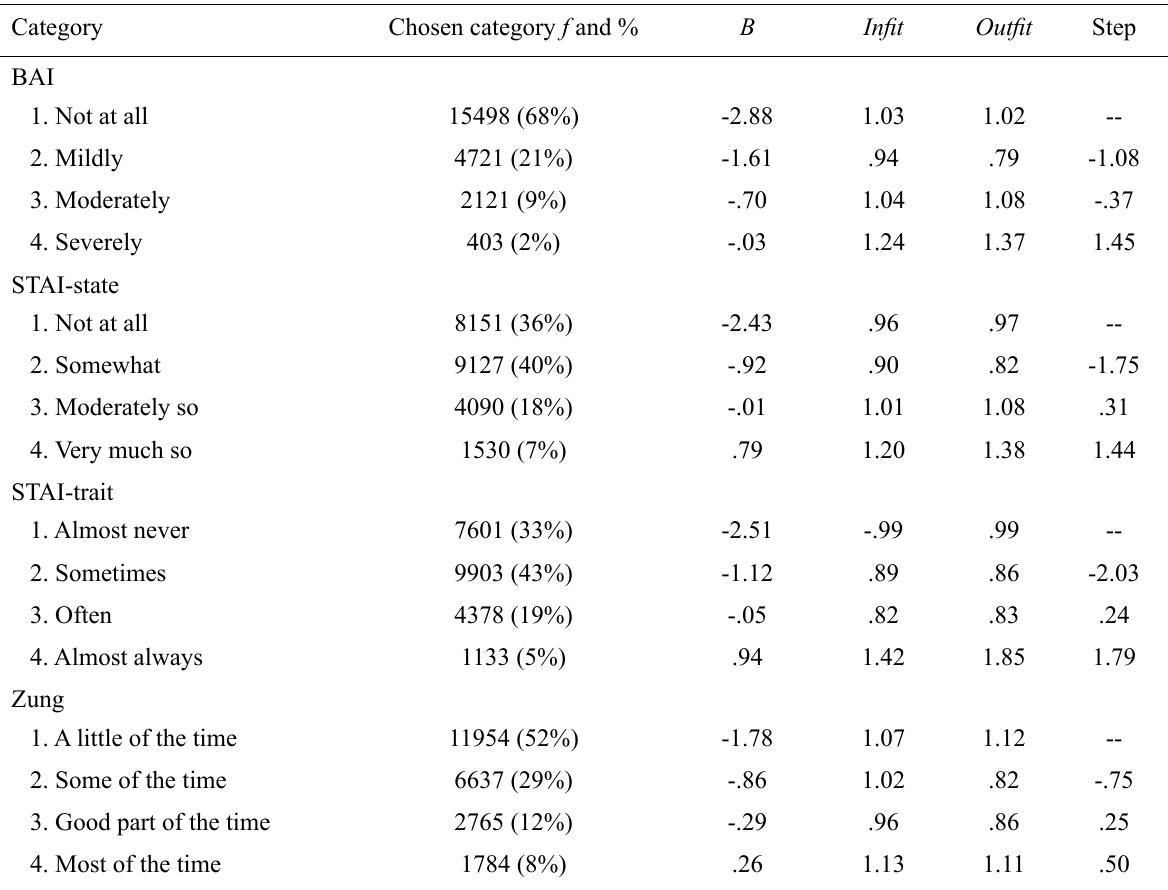
BAI, STAI-State, STAI-Trait and Zung Category Statistics